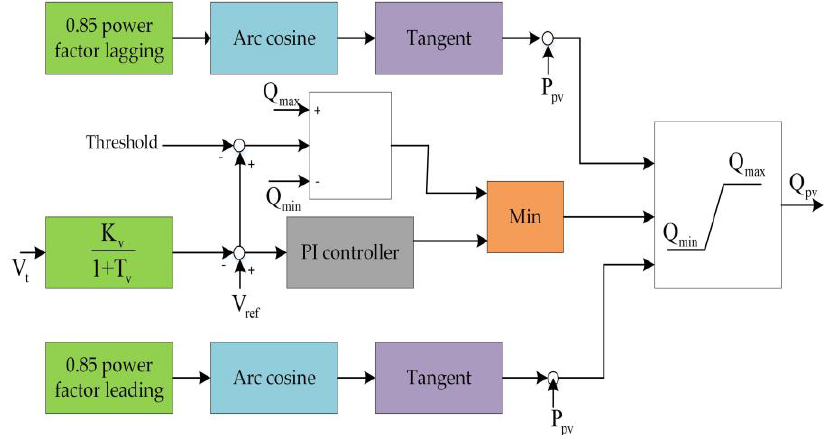
Figure 4. Automatic voltage control from a PV generator [27].